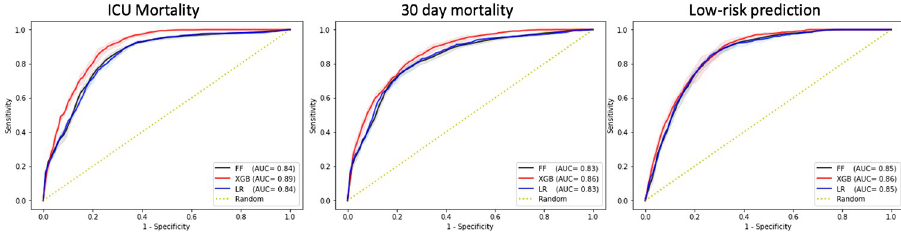
Fig 7. AUC performance of the model derived from the overall European cohort and externally validation in a cohort of Asian, African, and American patients for each of the three outcomes. AUC and AUPRC performance graphs of each model in internal cross-validation are available in Fig C in S3